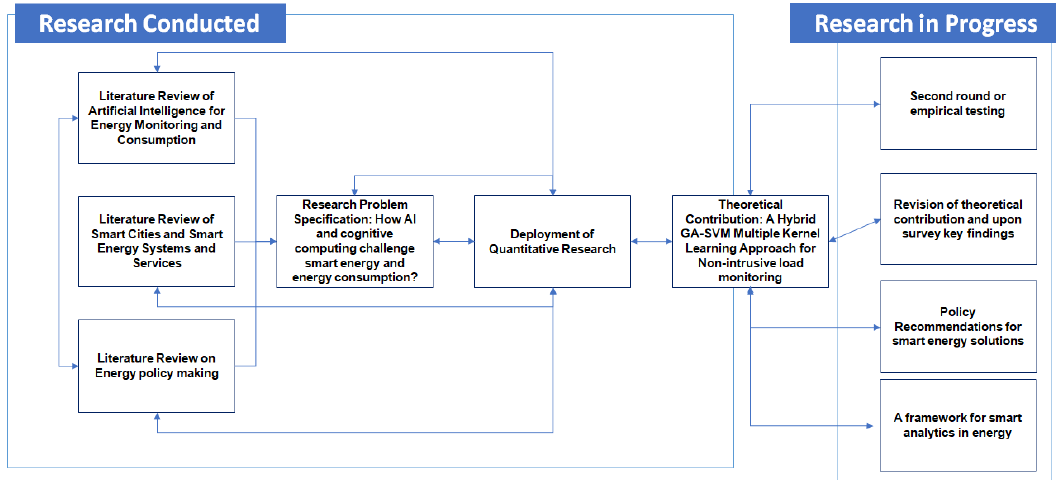
Figure 2. Flow chart of research methodology. AI, artificial intelligence; GA-SVM, generic algorithm support vector machine.